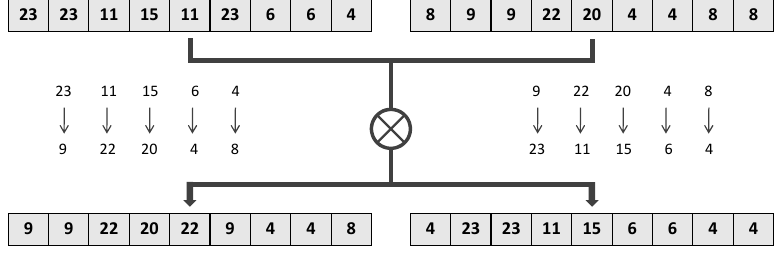
Figure 4. The crossover operation of two individuals.